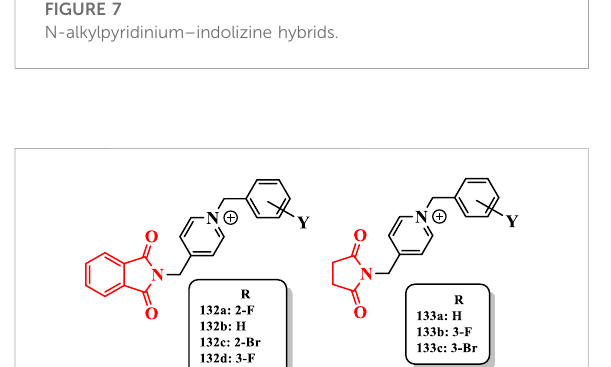
FIGURE 7 N-alkylpyridinium – indolizine hybrids.